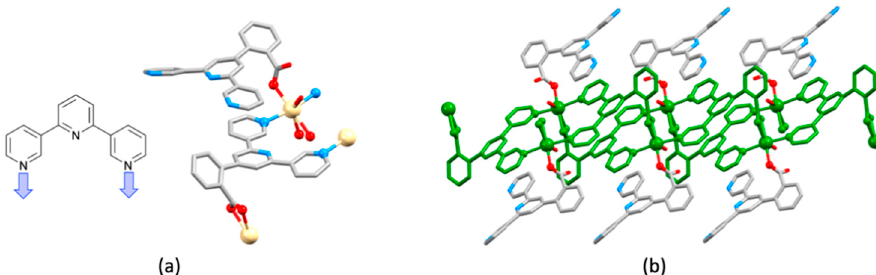
Figure 45. The structure of [Cd( 63 ) 2 (OH 2 )] n (CSD refcode MICTOK). ( a ) The asymmetric unit with symmetry generated atoms, and the planar conformation of both independent 3,2’:6’,3” ‐ tpy units. ( b ) A representation of part of the 1D-polymer illustrating the different roles of the two independent 63 – ligands; the ligands colored green comprise the polymer backbone, while the second ligands are peripheral to the assembly.